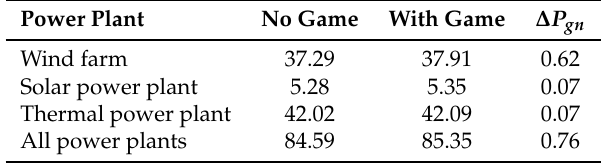
Table 7. Daily profit of power producers using different methods in the day-ahead market (10 4